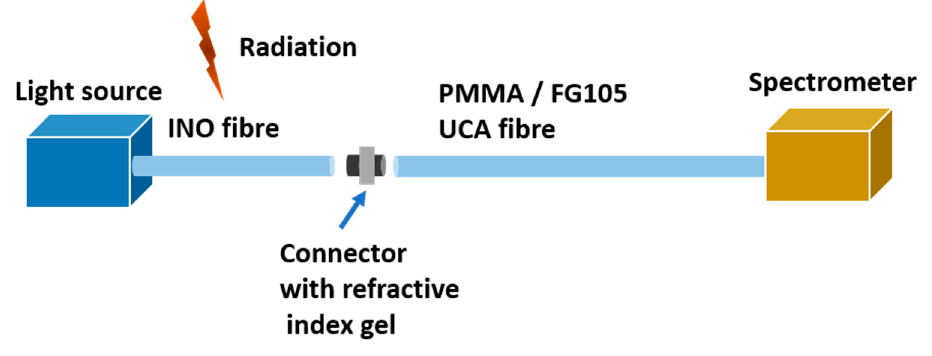
Figure 1. Setup of the experiment.